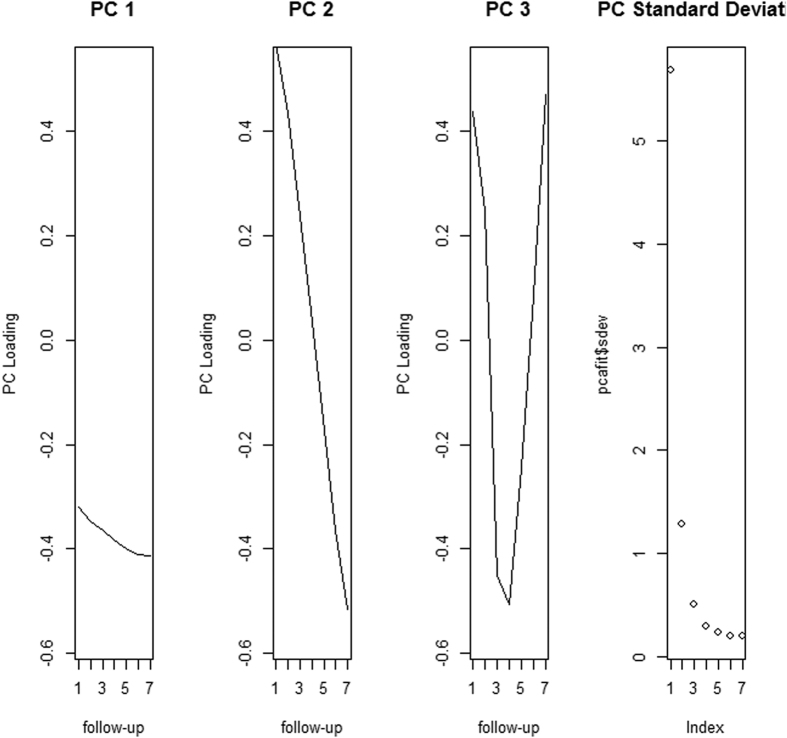
Component loadings plots of the first three principal components of longitudinal patterns in refraction.